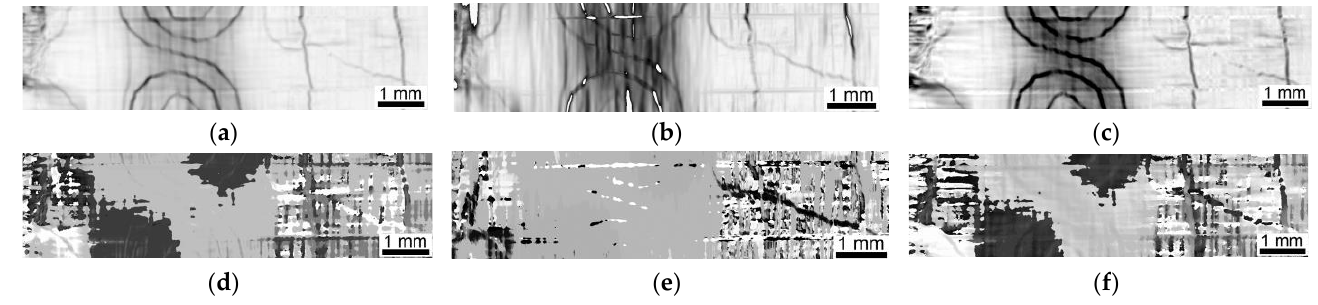
Figure 16. Pseudo images of shear amplitudes ( a − c ) and angles ( d − f ) for the shear components: shear ( a , d ), rupture ( b , e ) and their sum ( c , f ) at the first fracture stage. All pseudo-images on ( a – f ) were obtained under the following conditions: ε = 0.037, ∆ ε = 0.012, T = 1.